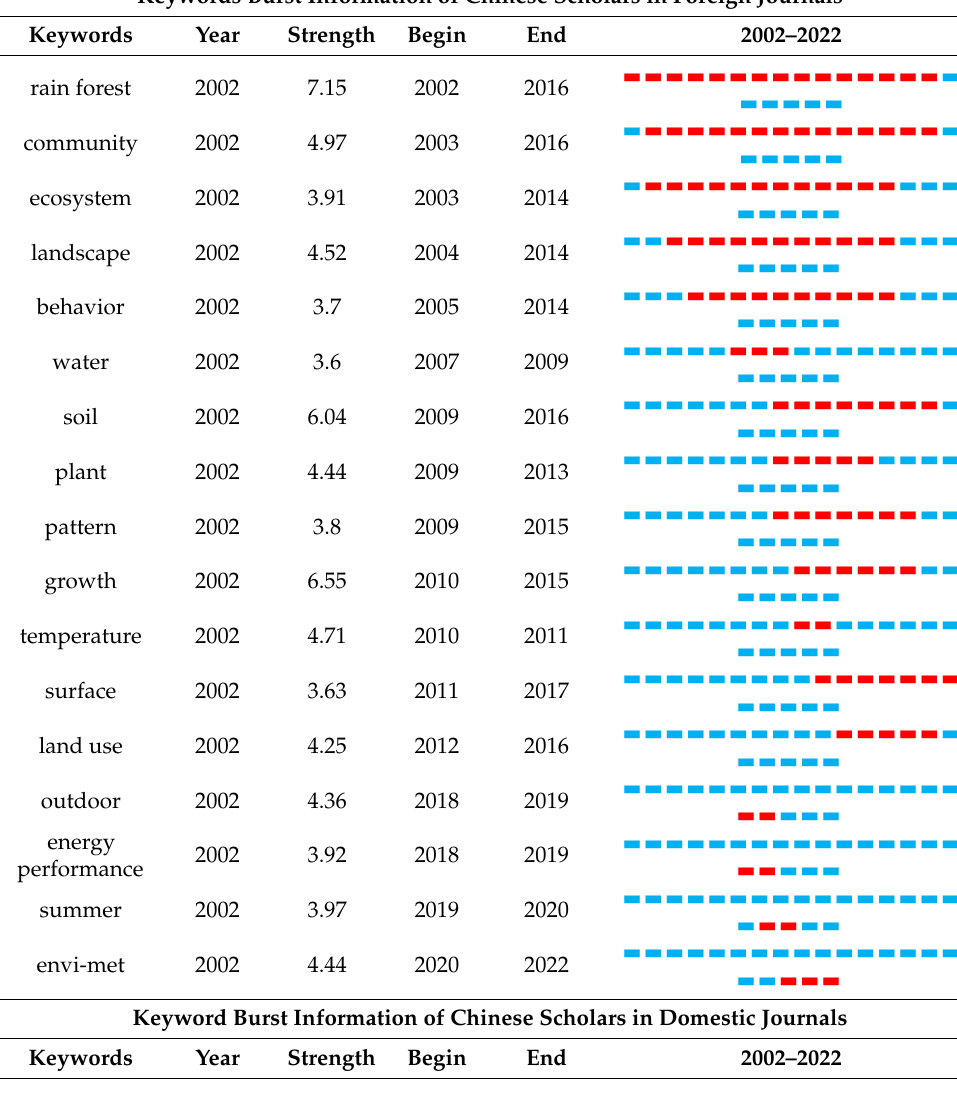
Table 2. Keywords bursting information table of Chinese landscape microclimate. Keywords Burst Information of Chinese Scholars in Foreign Journals Keywords